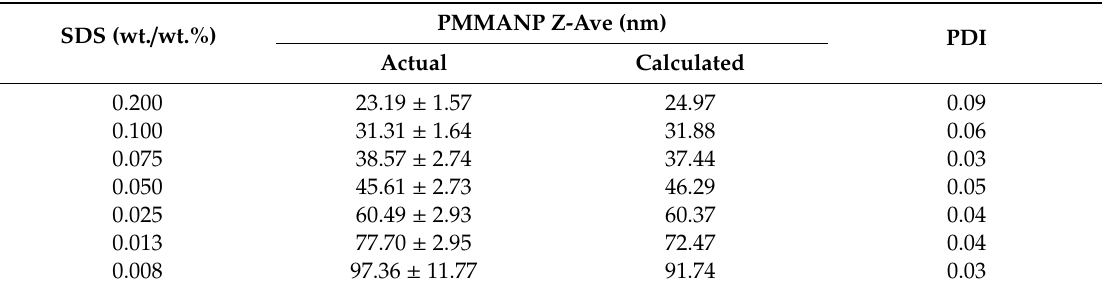
Table 1. Actual vs. Formula-calculated Sizes of poly(methyl methacrylate) (PMMA) nanoparticles (PMMANPs).